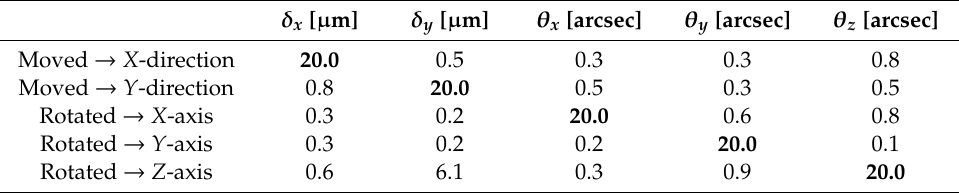
Table 2. Crosstalk errors of the LMS with